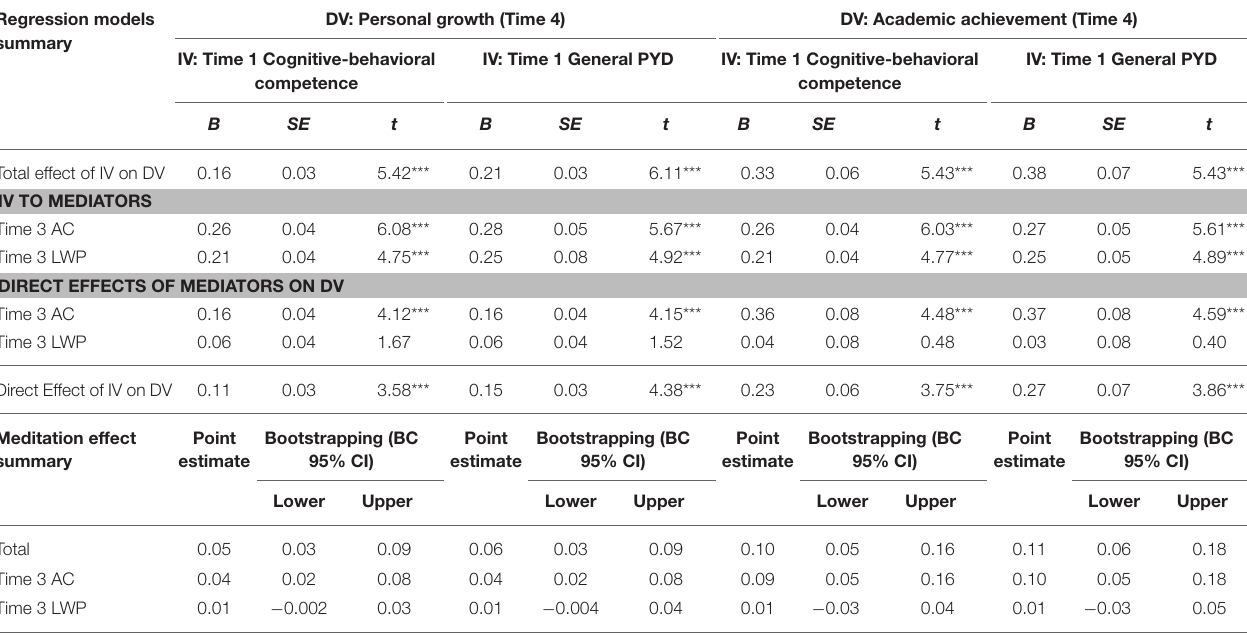
TABLE 3 | Mediation effect analyses with internal engagement at Time 3 as the mediator ( N = 425–427). Regression models